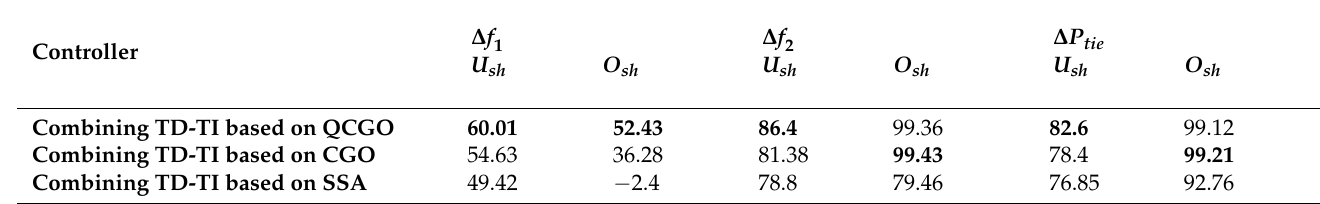
Table 13. Percentage improvement in U sh and O sh values for combining TD-TI/QCGO and PID/AOA based on PID controller via TLBO for scenario